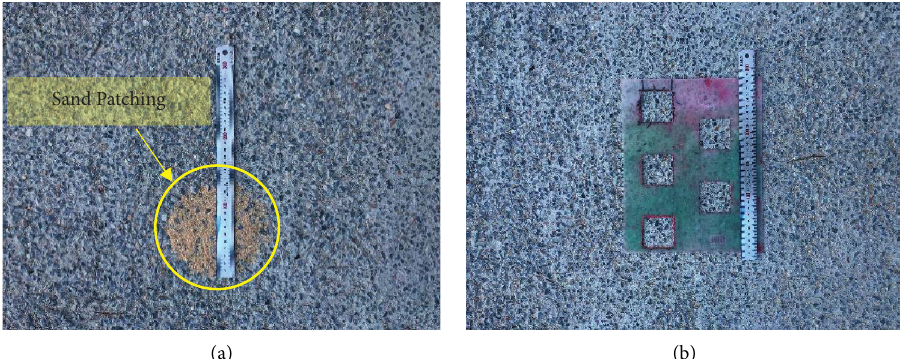
Figure 5: Measurement of surface texture parameters in the field: (a) mean texture depth measurement in the field; (b) exposed aggregate number measurement in the field.